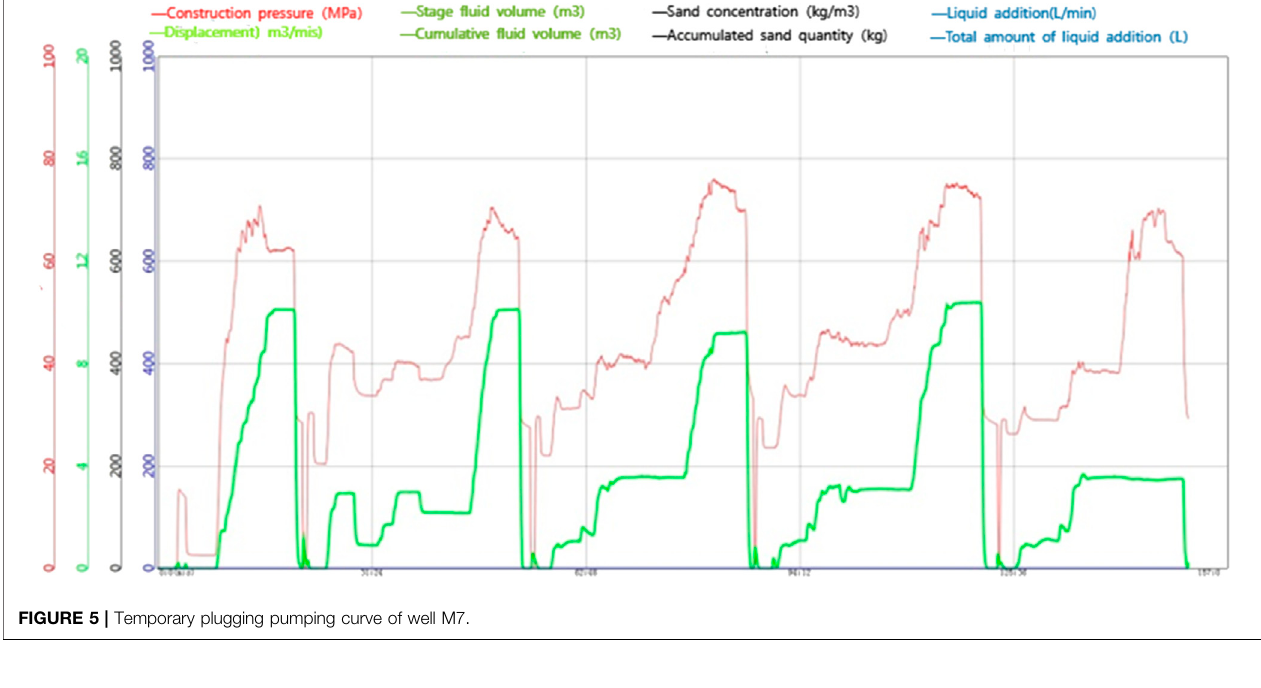
FIGURE 5 | Temporary plugging pumping curve of well M7.